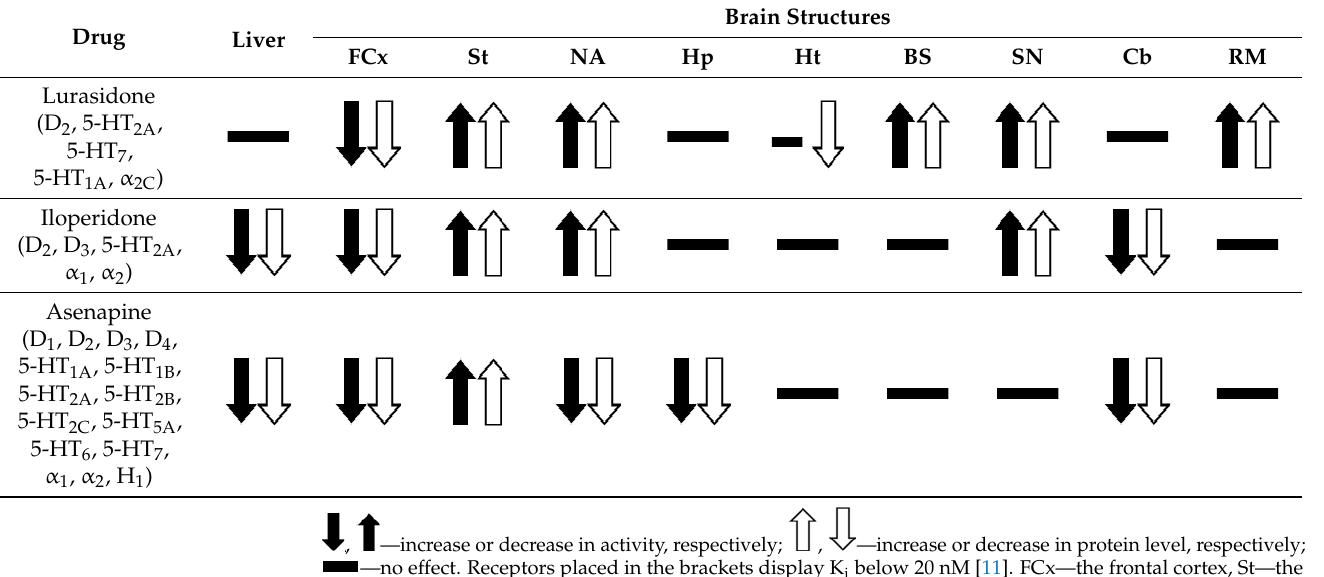
Table 2. The effects of novel atypical neuroleptic drugs on the CYP2D activity and protein level in the liver and brain .